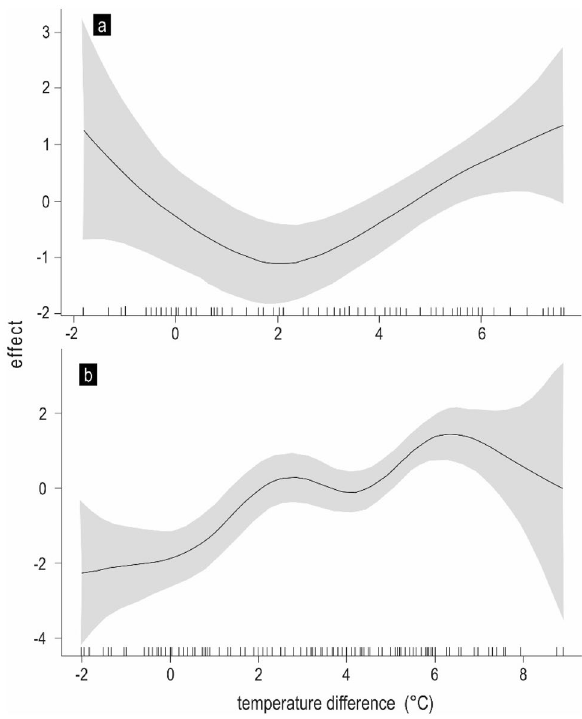
Figure 4. Effect of differences between temperatures in the Lino Reservoir and its tributary, the Vltava River, on the probability of A. brama ( a ) and S. cephalus ( b ) occurrence in the tributary. The solid line is an estimate of s difT ; the shaded region shows (pointwise constructed) 95% confidence intervals for given temperature difference